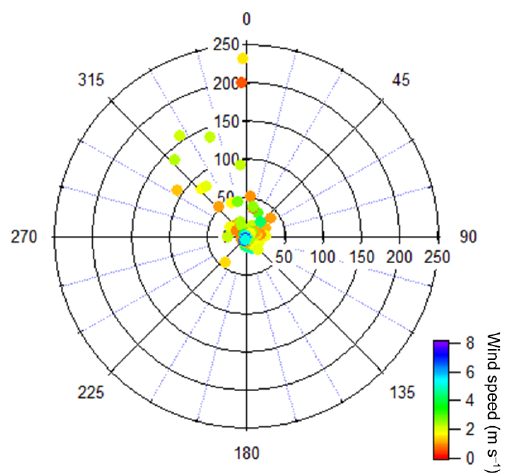
Figure 5. Time series of winter combustion related to traffic (F2), gasoline evaporation (F4 and F5), factors contribution, and CO in µgm − 3 .